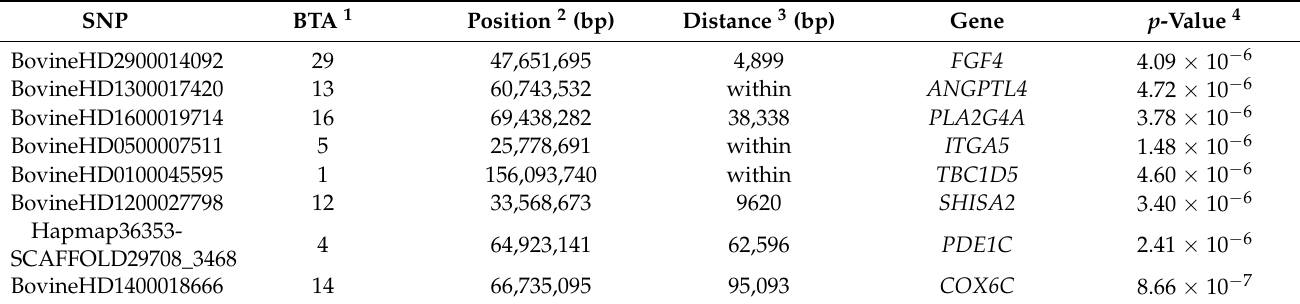
Table 2. The most important candidate genes affecting body weight